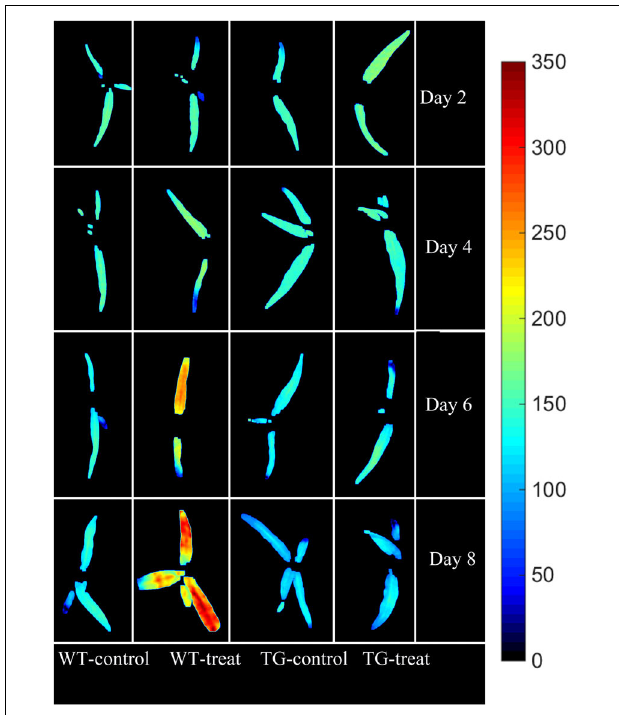
FIGURE 7 | Visualization of the response (over time) of shikimic acid concentration to glyphosate treatment in WT and TG maize. The color bar, from blue to red, shows increasing levels of shikimic acid